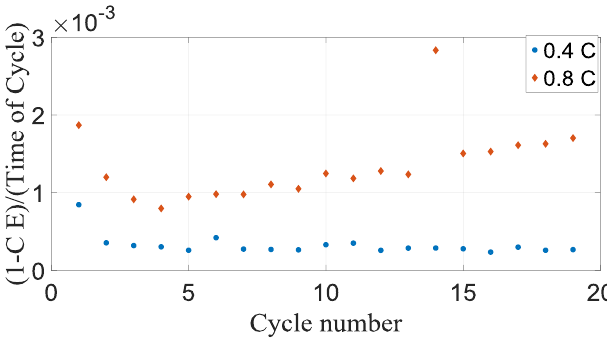
Figure 6. Coulombic inefficiency divided by time of each cycle vs cycle number.